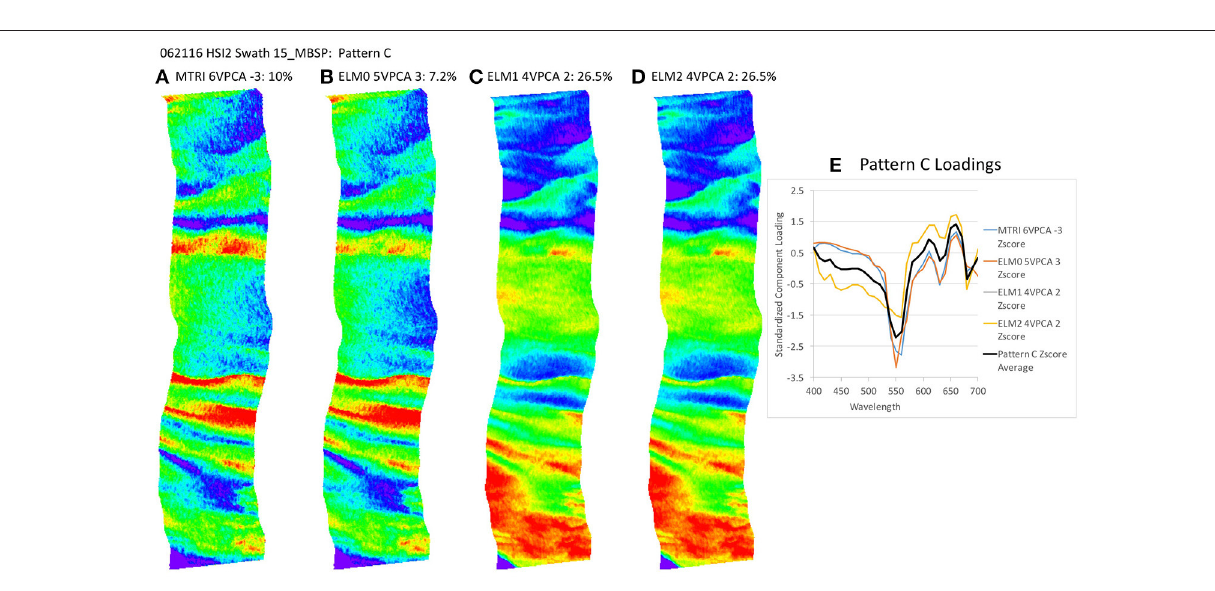
FIGURE 10 | Spatial distribution of varimax-rotated principal component analysis (VPCA) component pattern C. (A) Michigan Tech Research Institute (MTRI) correction method decomposition. (B) Empirical Line Method 0 (ELM0) correction method decomposition. (C) Empirical Line Method 1 (ELM1) correction